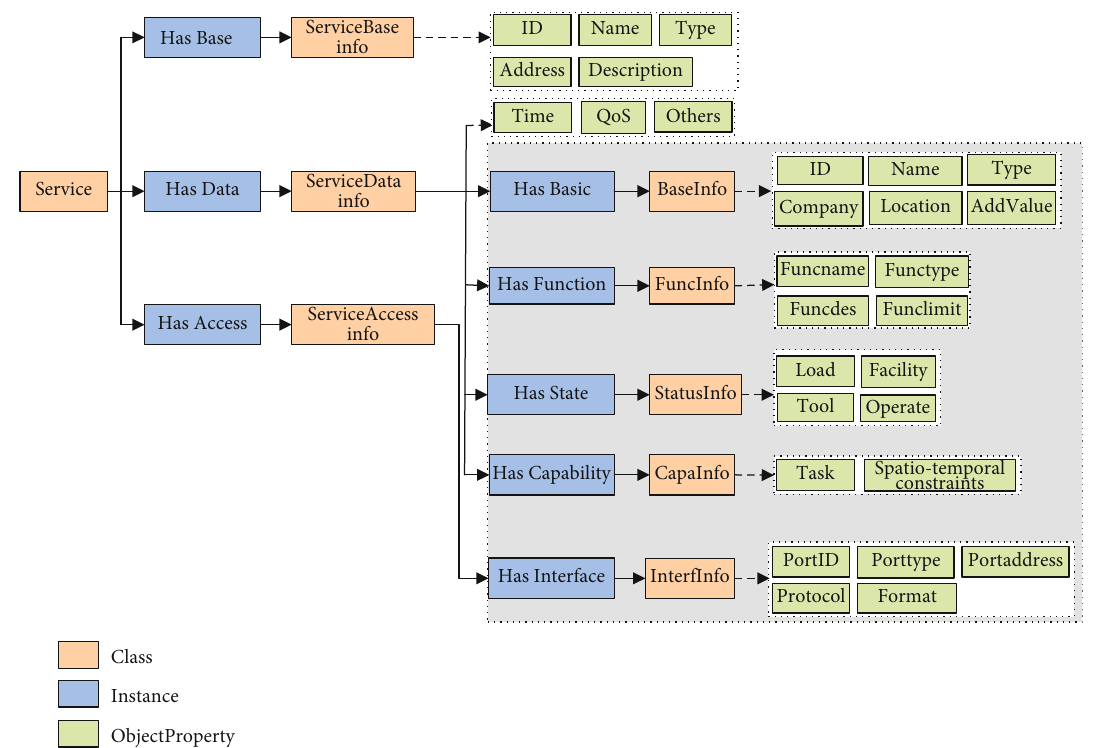
Figure 3: Ontology-based resource service for avionics